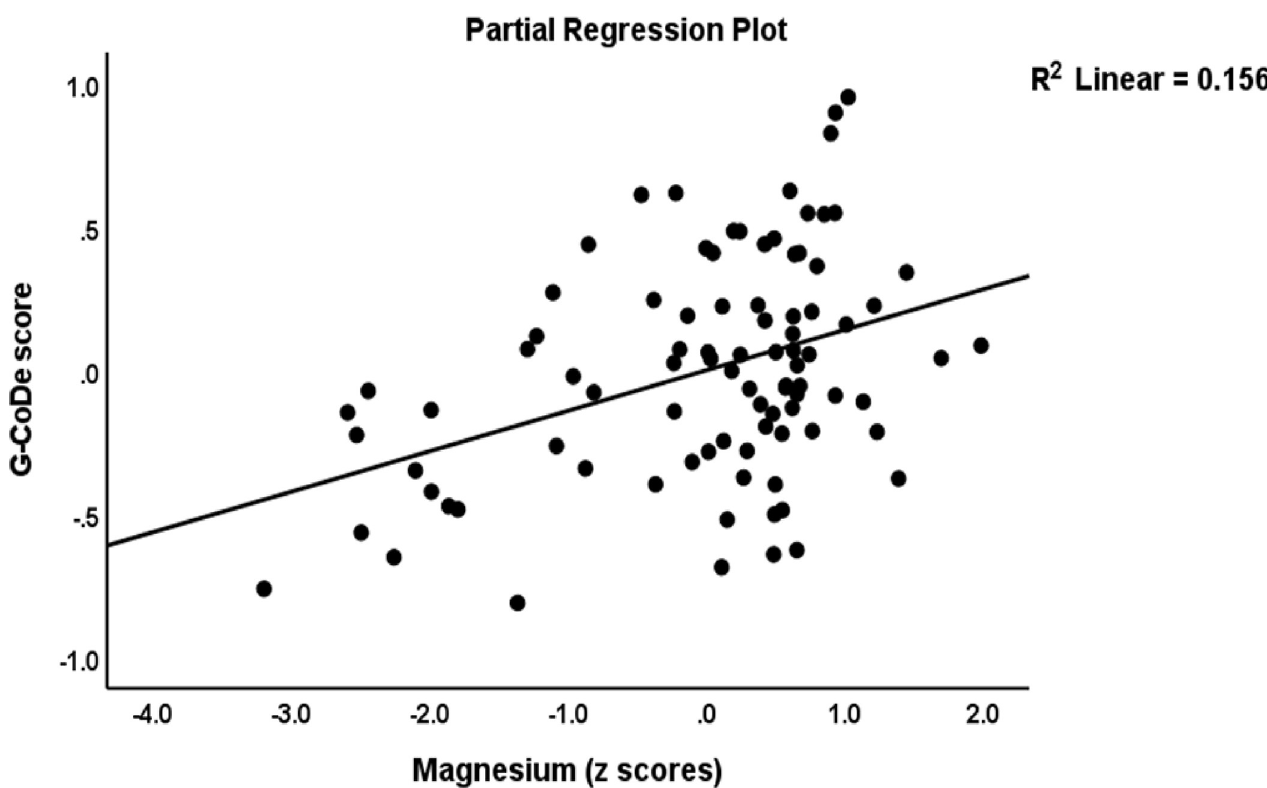
Fig 5. Partial regression plot of the generalized cognitive deteroriation (G-CoDe) score on serum magnesium concentrations.